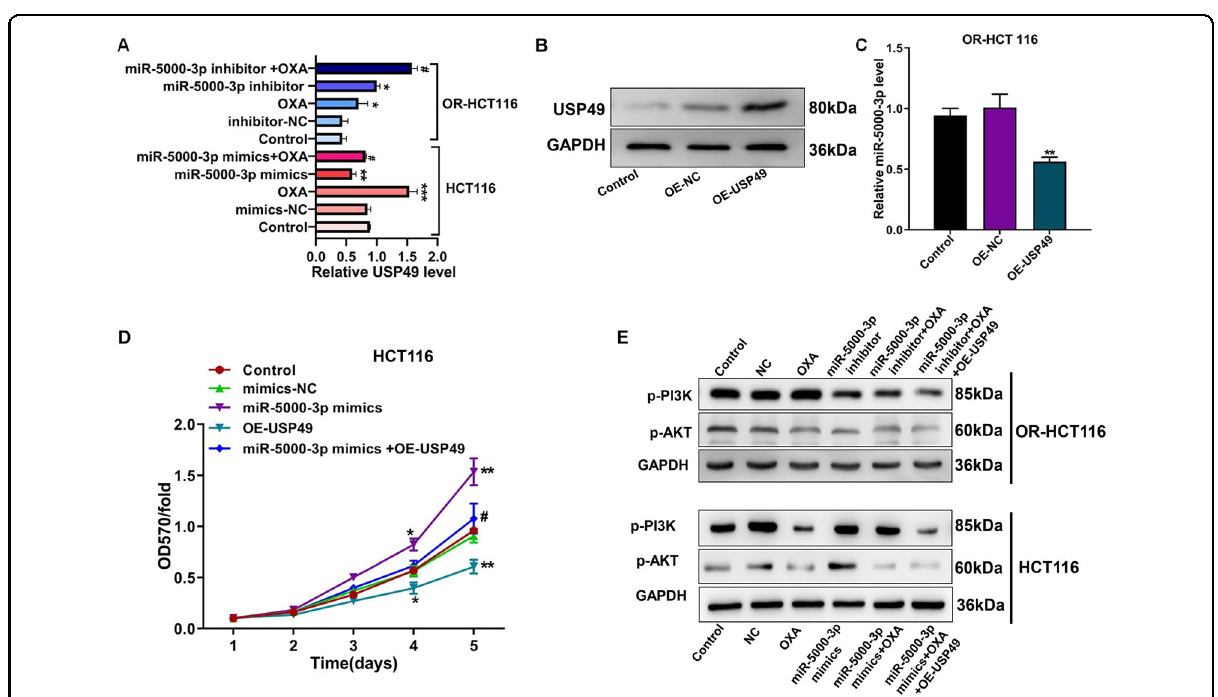
Fig. 6 miR-5000-3p regulates PI3K/AKT signaling pathway by targeting USP49 in CRC or OR-CRC cells. A Relative mRNA level of USP49 in HCT116 or OR-HCT116 cells transfected with a miR-5000-3p mimics, or inhibitor, or treatment with OXA. B Protein expression of USP49 in OR-HCT116 cells after transfected with HSP49 overexpression or NC vectors were detected by western blot. C miR-5000-3p expression after transfections with USP49 overexpression or NC vectors in OR-HCT116 cells. D MTT assay was used to detect cell proliferation viability in different groups following 5 days. E Western blot showing the protein level of PI3K/AKT signaling relevant markers, includes p-PI3K and p-AKT. * p < 0.05, ** p < 0.01, and *** p < 0.001 vs Control or NC; # p < 0.05 vs inhibitor or